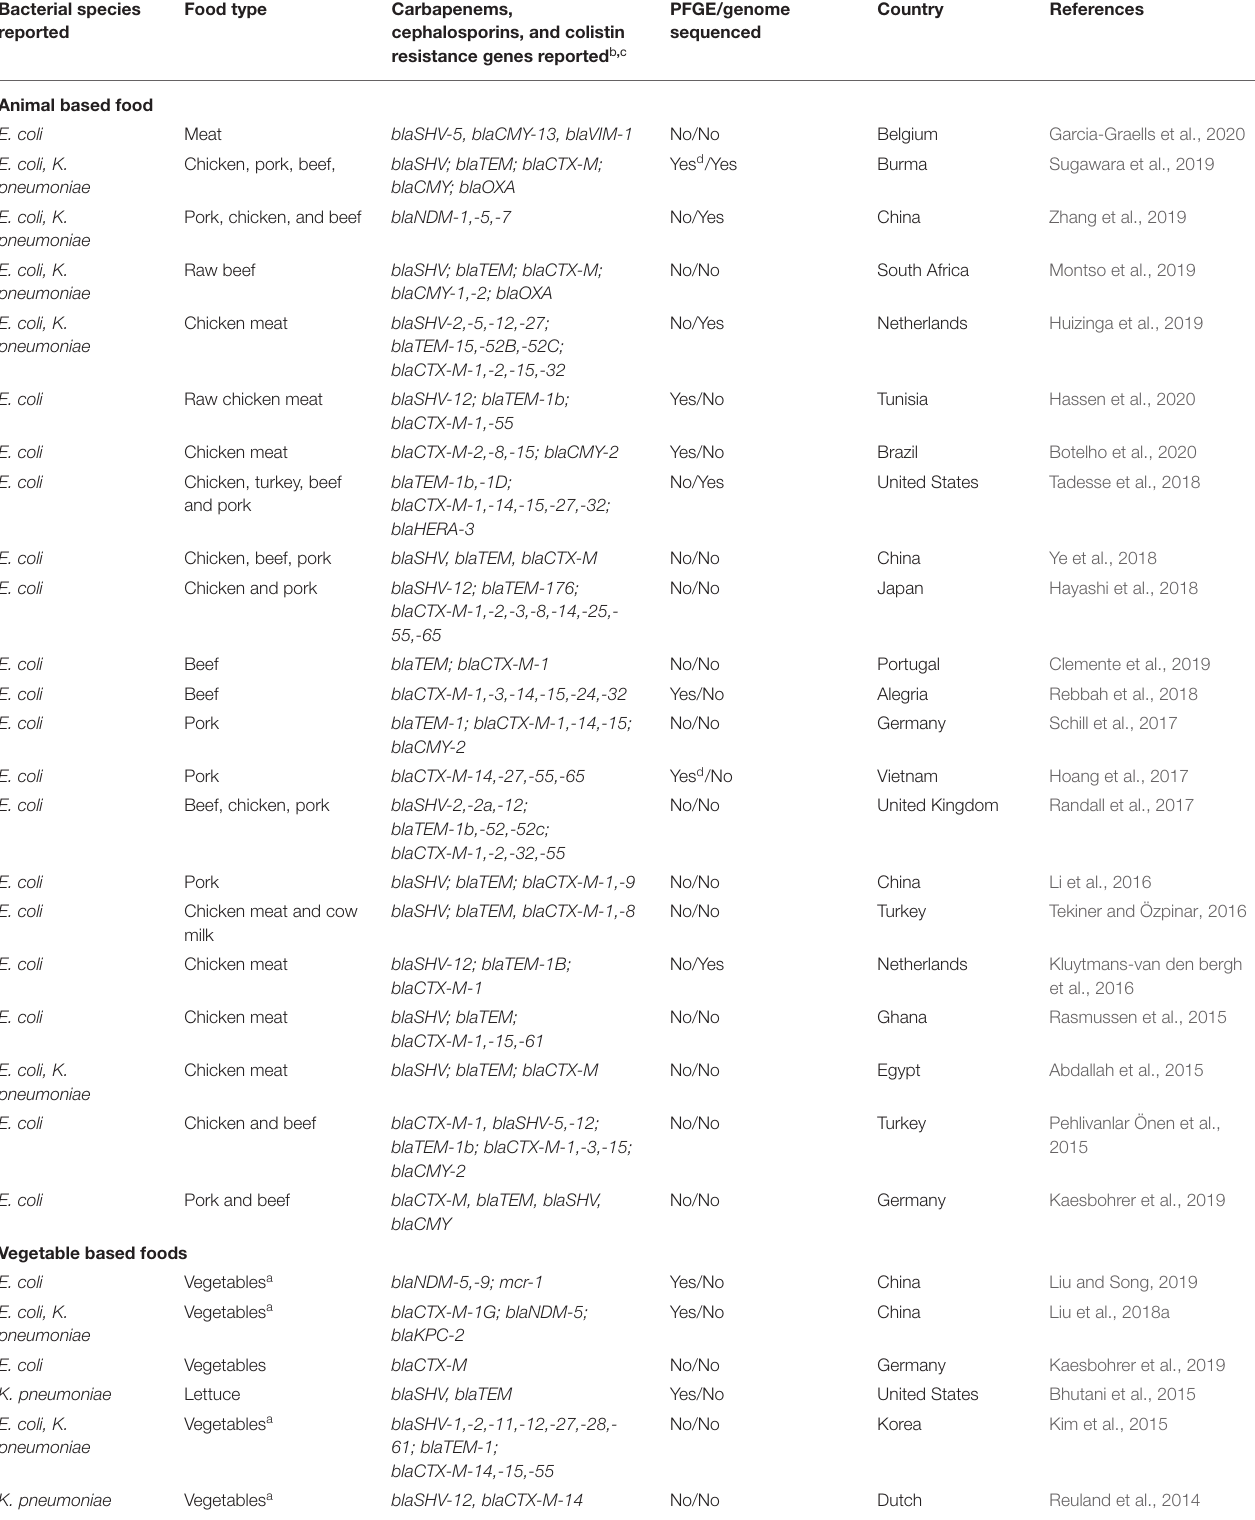
TABLE 1 | Selected reports of clinically relevant antimicrobial resistant bacteria in different